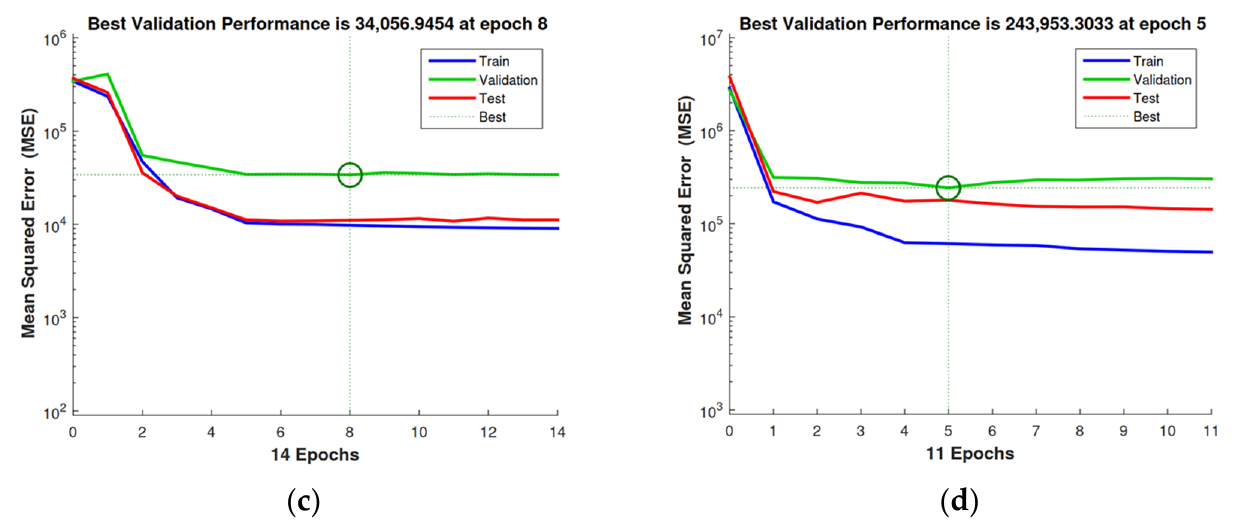
Figure 3. ( a ) H85—MSE of Method II—Workdays; ( b ) H85—MSE of Method II—Weekend; ( c ) H85—MSE of Method III—Working days; ( d ) H85—MSE Method III—Weekend.